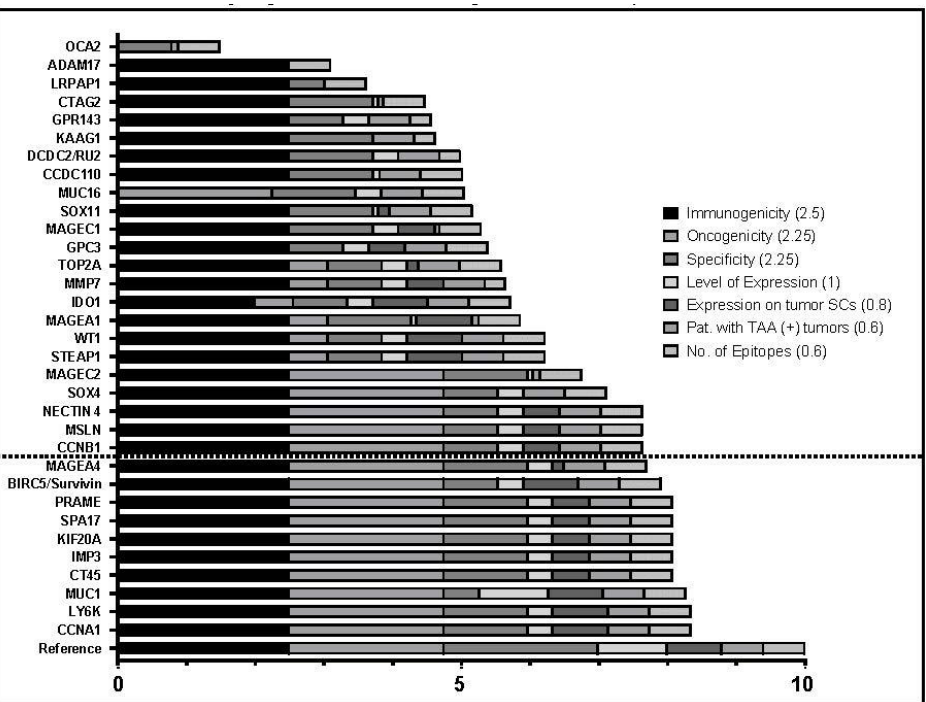
Figure 2. Bar chart depicting the results of TAA prioritization with weighted criteria for each TAA, modified after Cheever et al. [27]. A maximum score of 10 points was attainable. Legend shows color coded evaluation criteria and the maximum points attainable in brackets; Bottom bar shows a reference with the maximum points in each of the seven categories; Dotted line marks the ten highest rated targets.